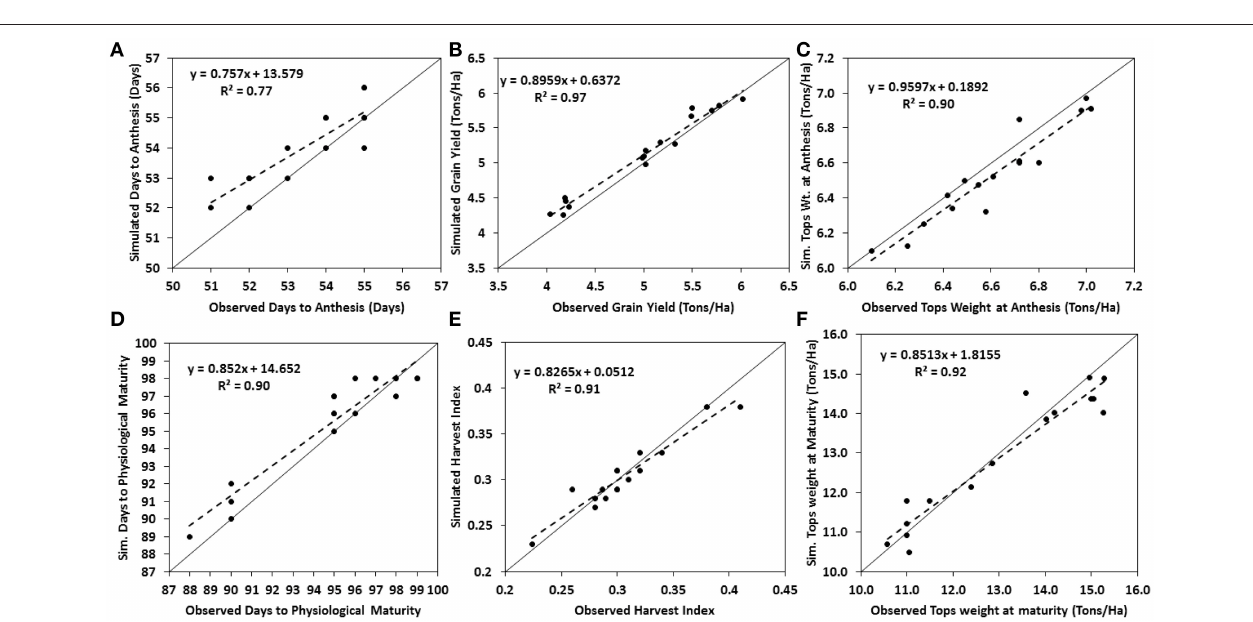
FIGURE 4 | Comparisons of observed and simulated variables for the calibration of EVDT. Solid lines represent 1:1 relationships, dashed line represents linear regression, and each point represents a plot for both dry and rainy seasons. (A) Days to Anthesis; (B) Grain Yield, (C) Tops Weight at Anthesis, (D) Days to Physiological maturity, (E) Harvest Index, and (F) Tops Weight at Maturity.